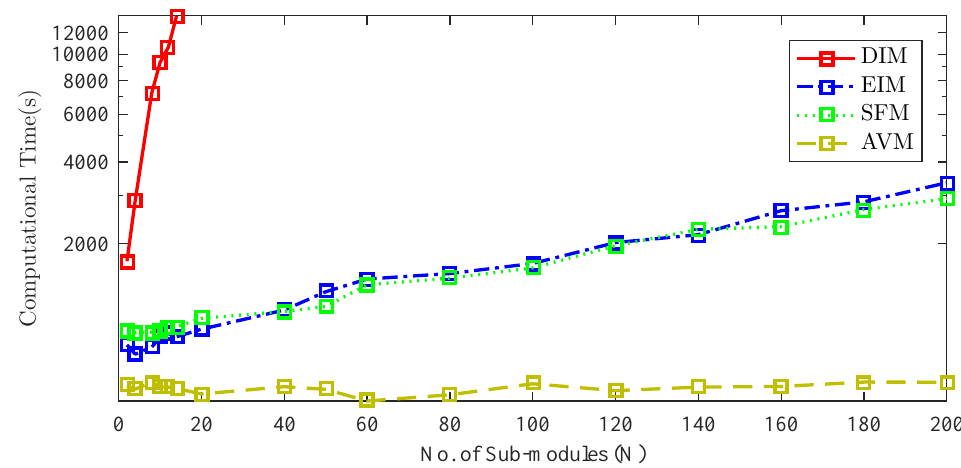
Figure 14. Computational burden of the MMC